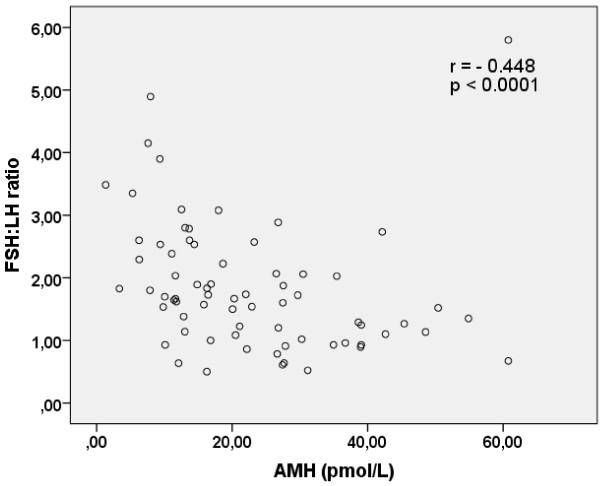
Correlation between serum AMH and the FSH:LH ratio. Correlation between serum AMH levels and the FSH:LH ratio in 71 infertile women with diagnosis unexplained infertility and male infertility. Spearman’s correlation analysis was used. A value of p < 0.05 was considered statistically significant.